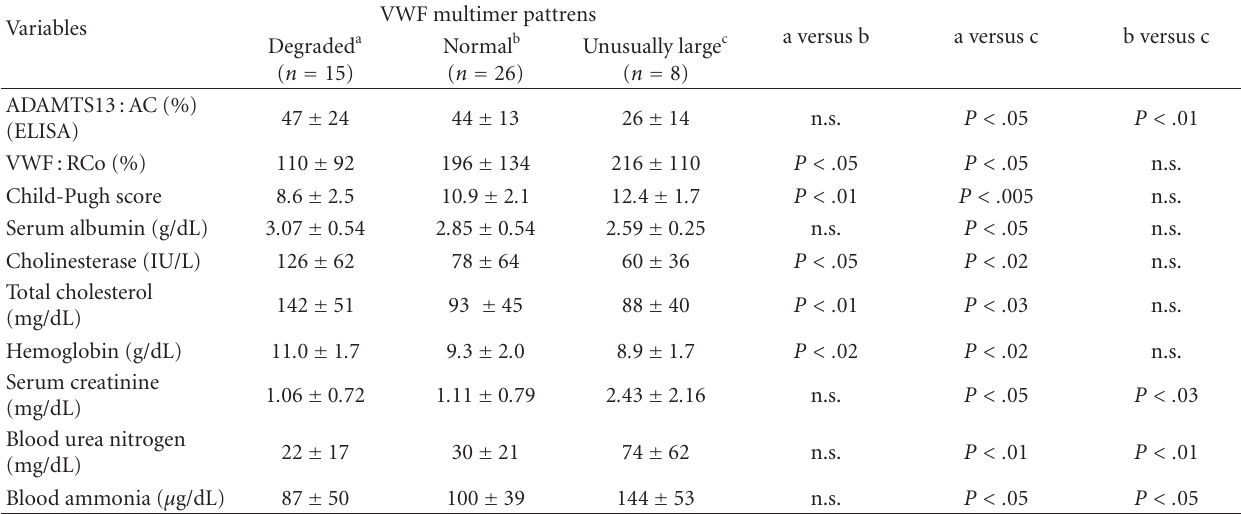
Table 1: Comparison of clinical parameters among cirrhotic patients according to VWF multimer patterns. VWF multimer pattrens Variables